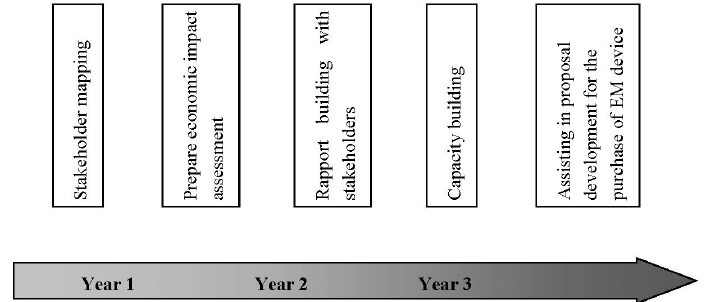
Figure 2. Roadmap of the Salinity Assessment Team.